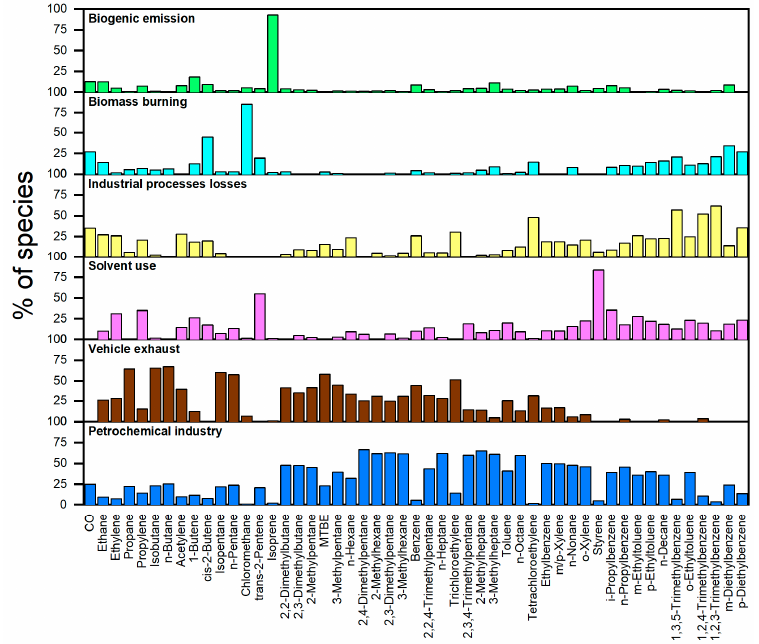
Figure 10. Source profiles derived from the PMF model at the HGS site.